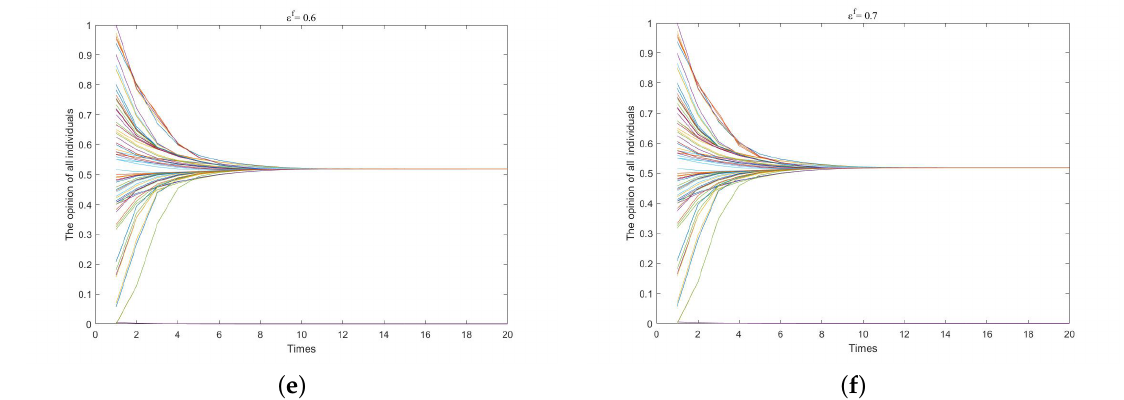
( e ) ( f ) Figure 6. The opinion evolution of all individuals with different confidence levels of the followers.